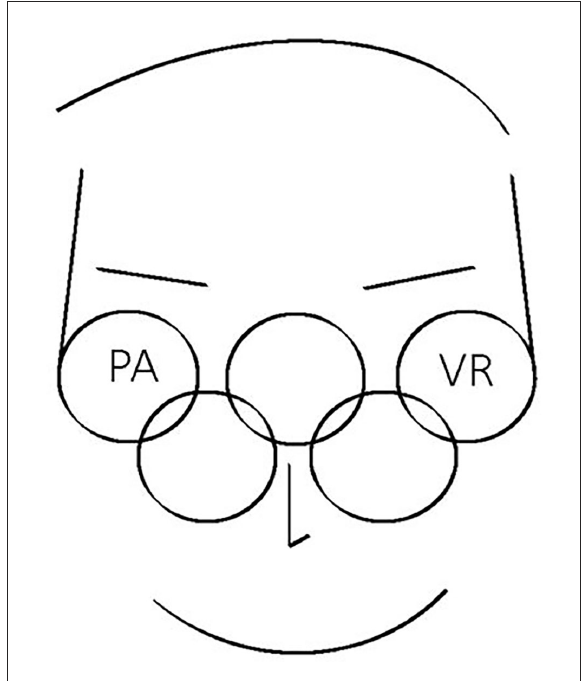
FIGURE1 How do you perceive the world through the lens of virtual reality